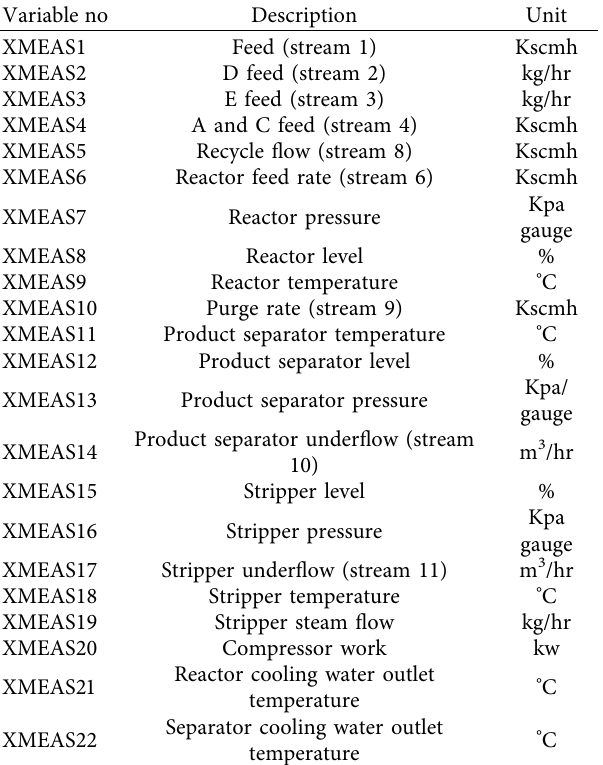
Figure 8: TE model process fow chart. Table 1: Description of continuous process variables of TE process. Table 2: True root causes for tested fault conditions